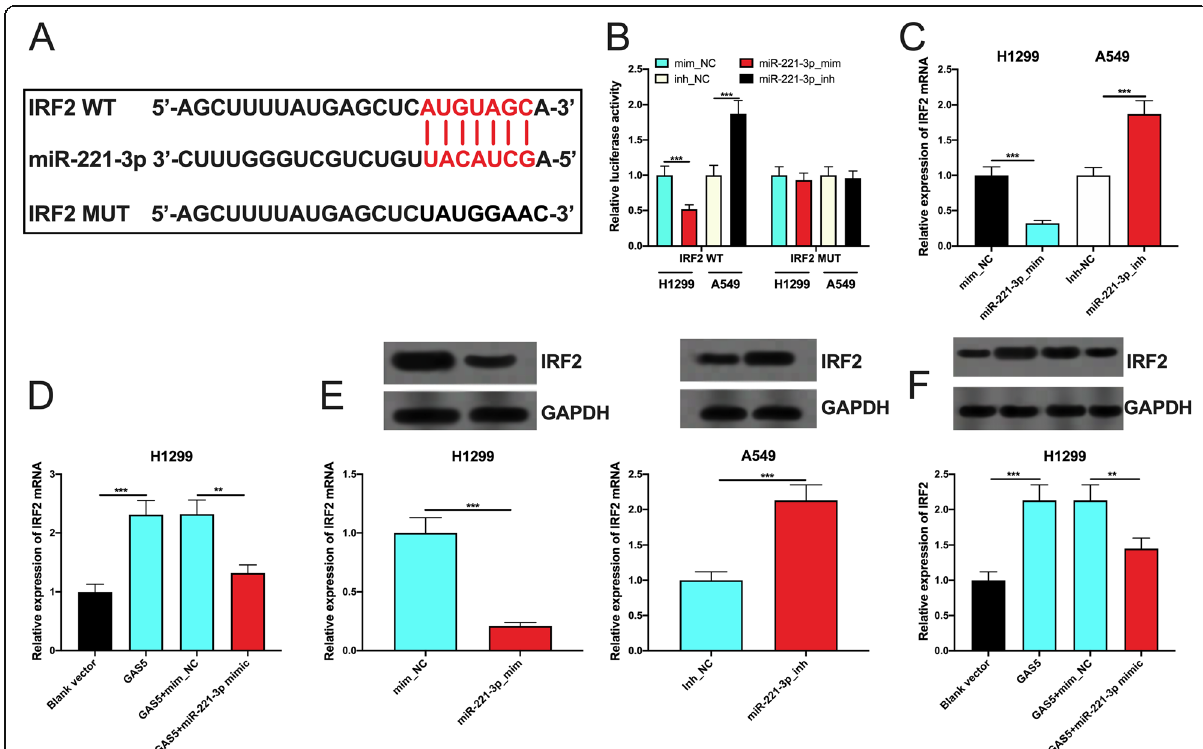
Fig. 6 Regulatory effects of GAS5 and miR-221-3 on IRF2 expression in NSCLC cells. a The binding sequence between miR-221-3p and IRF2 3 ’ UTR. b Binding sites between miR-221-3p and IRF2 3 ’ UTR were verified using dual-luciferase reporter gene experiments. c , d The regulatory effects of miR-221-3p and GAS5 on IRF2 mRNA expression in NSCLC cells were detected by qPCR. e , f The effects of miR-221-3 and GAS5 on IRF2 protein expression in NSCLC cells were detected by Western blot. ** and *** represent p < 0.01 and p < 0.001,